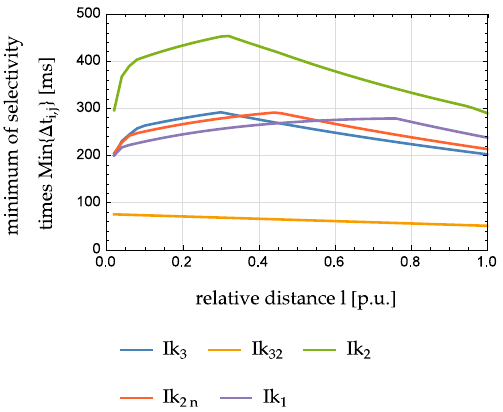
Figure 13. Dependence of the minimum selectivity times Min { ∆ tm i,j } on relative distance l for IEEE 6-bus power system where all required short-circuit types are considered.